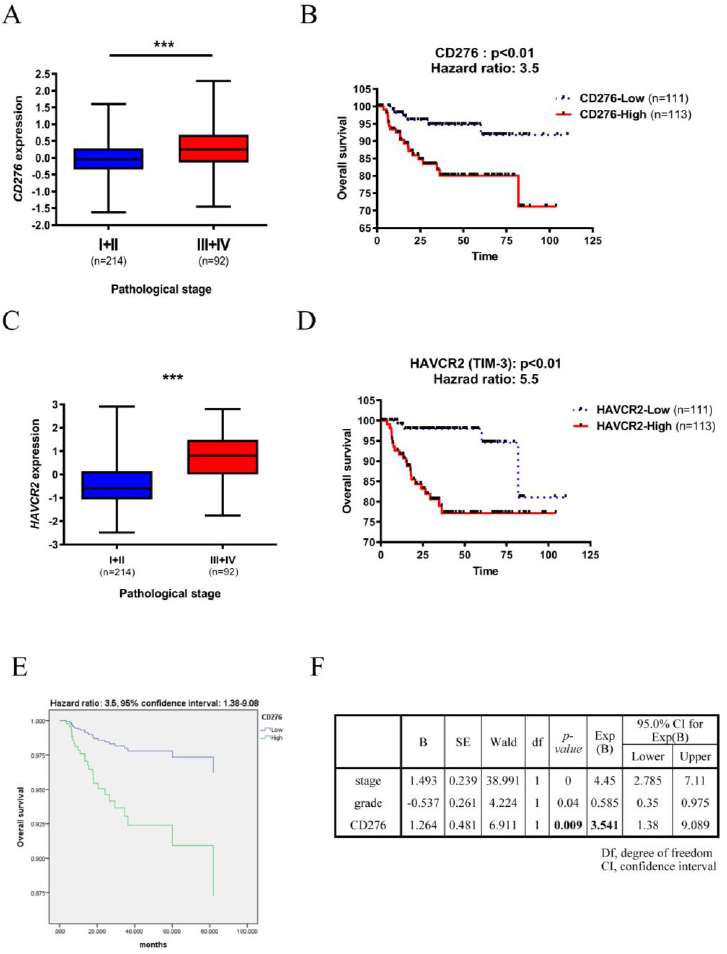
Figure 1. CD276 and TIM-3 expression positively correlates with the poor prognosis of UC. GEO dataset (GSE32894) was analyzed to determine the clinical significance of UC. ( A ) CD276 ( C ) HAVCR2 ( TIM-3 ) expression was grouped by early pathological stage (I + II) and late-stage (III + IV). ( B , D ) Overall survival of 224 UC patients was grouped by lower and higher ( B ) CD276 ( D ) TIM3 expression using the median value as a cut-off. Kaplan-Meier survival analysis was performed. ( E ) Multivariate Cox regression survival plot of 224 patients with UC was grouped by lower ( n = 111) and higher ( n = 113) CD276 expression using the median value as the cut-off. ( F ) Results of the CD276 multivariate analysis. *** p < 0.001.